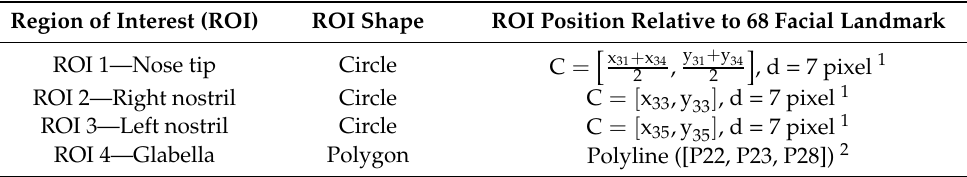
Table 3. Geometrical features of the considered